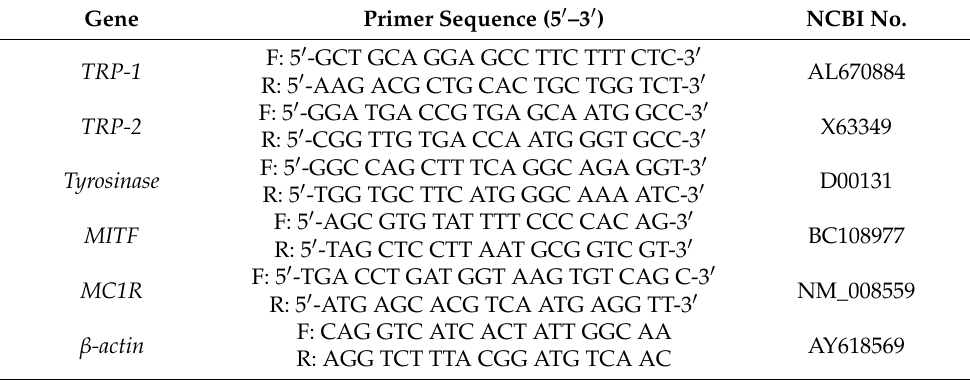
Table 3. Oligonucleotide primer sequences used for a quantitative real-time polymerase chain reaction. Gene Primer Sequence (5 (cid:48) –3 (cid:48)